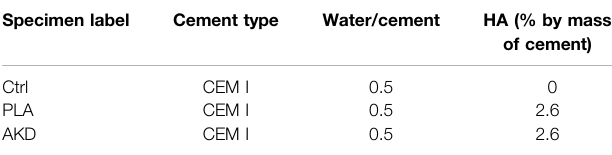
TABLE 2 | Composition of healing agents after particle formulation. TABLE 3 | Composition of samples analyzed through isothermal